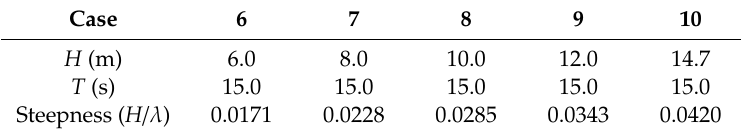
Table 6. Regular wave parameters with incident wave period T = 15.0